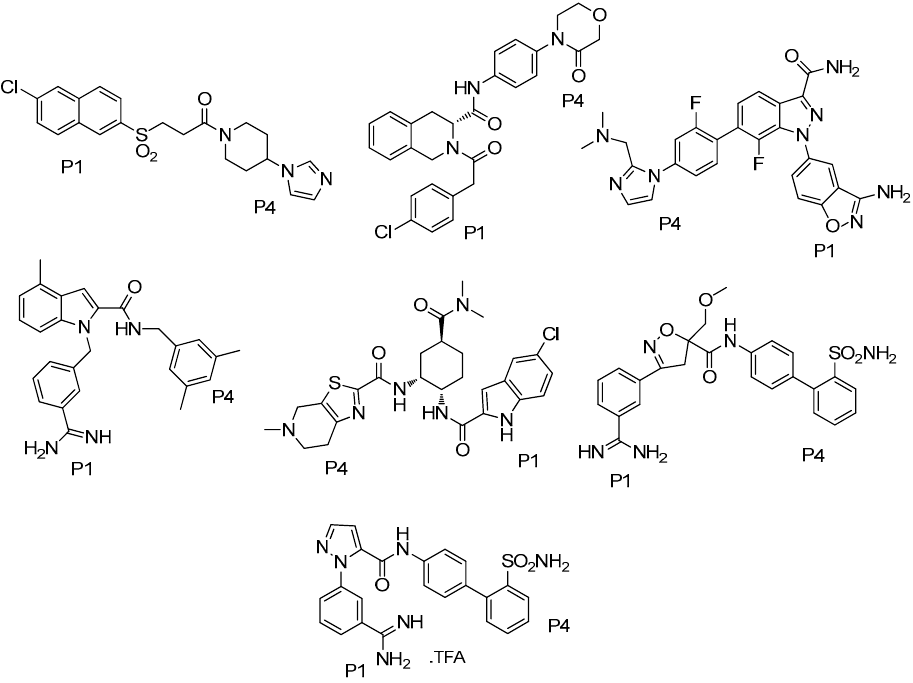
Figure 3. Examples of the molecules with typical structure.